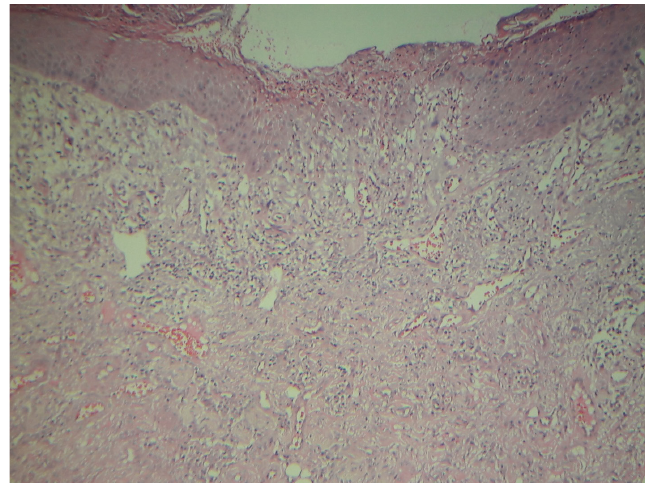
Figure 2: Orthokeratinized stratified squamous epithelium with solar elastoses in the lamina